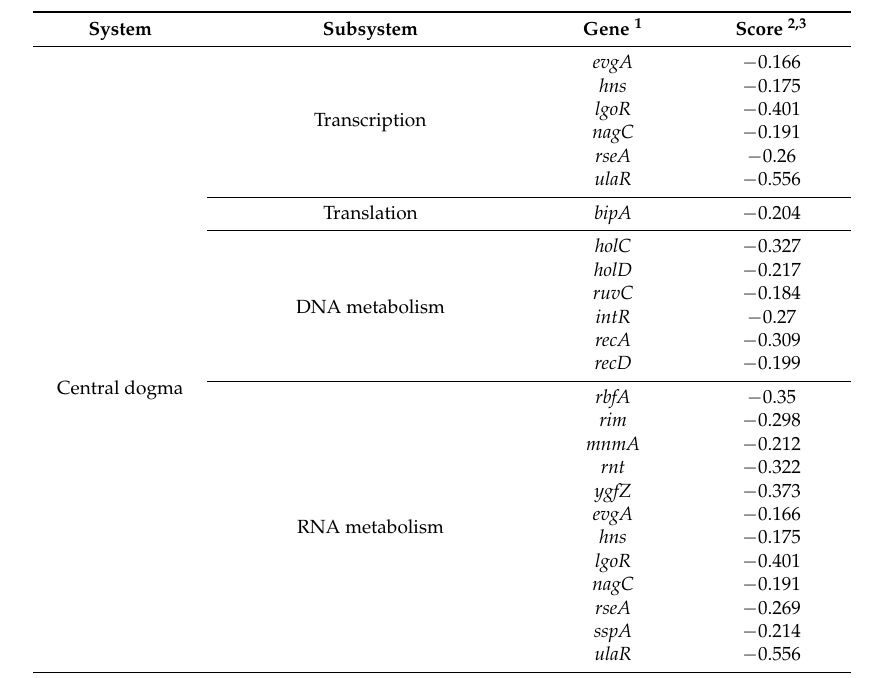
Figure 1. Synthetic Array Tools (version 1.0) was used to normalize and score the Gallium(III) (Ga) resistant and sensitive hits as a means of representing the growth differences in Escherichia coli K12 BW25113 in the presence of 100 μ M Ga(NO 3 ) 3 . Each individual score represents the mean of 9–12 trials. In this work, the absence of the gene was inferred to give rise to the Ga resistant or -sensitive phenotype. A decrease in colony size (normalized score < − 0.154) signified a Ga-sensitive hit, which implied that the presence of this gene increased Ga resistance. Here, 58 genes were found to cause Ga sensitivity when absent (Table 1). Likewise, an increase in colony size (normalized score > 0.162) signified a Ga-resistant hit, therefore the presence of this gene may suggest an increase in toxicity. Comparably, 49 genes were found to impart resistance when absent (Table 2), within the cutoffs applied. Table 1. Ga sensitive hits organized according to system and subsystem mined using the Omics Dashboard (Pathway Tools), which surveys against the EcoCyc Database; genes represent sensitive hits with scores < −